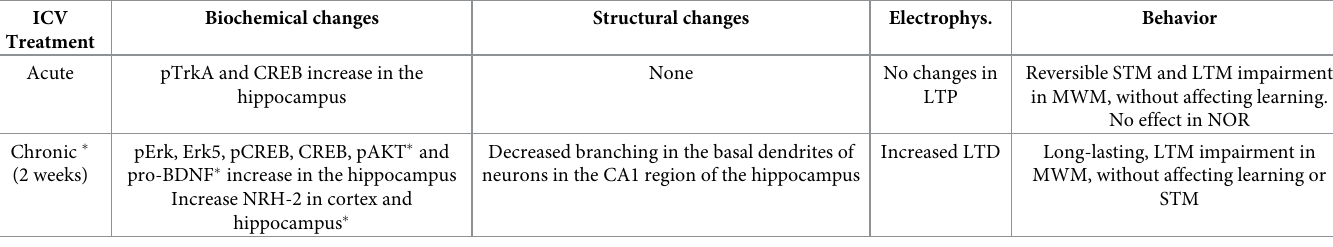
Table 1. Summary of